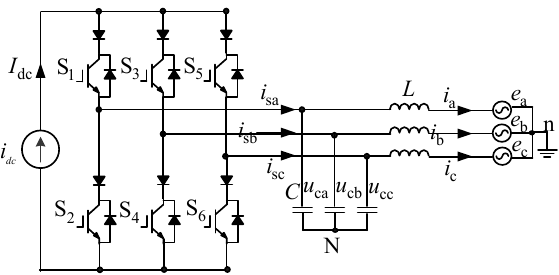
Figure 2. Schematic diagram of current source converter.